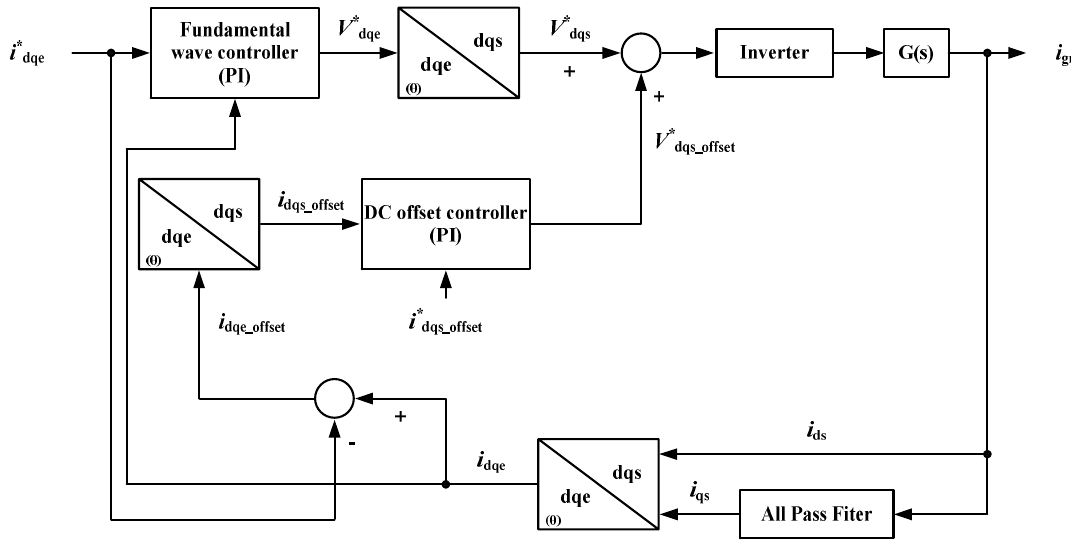
Figure 6. Block diagram of DC offset compensation method.